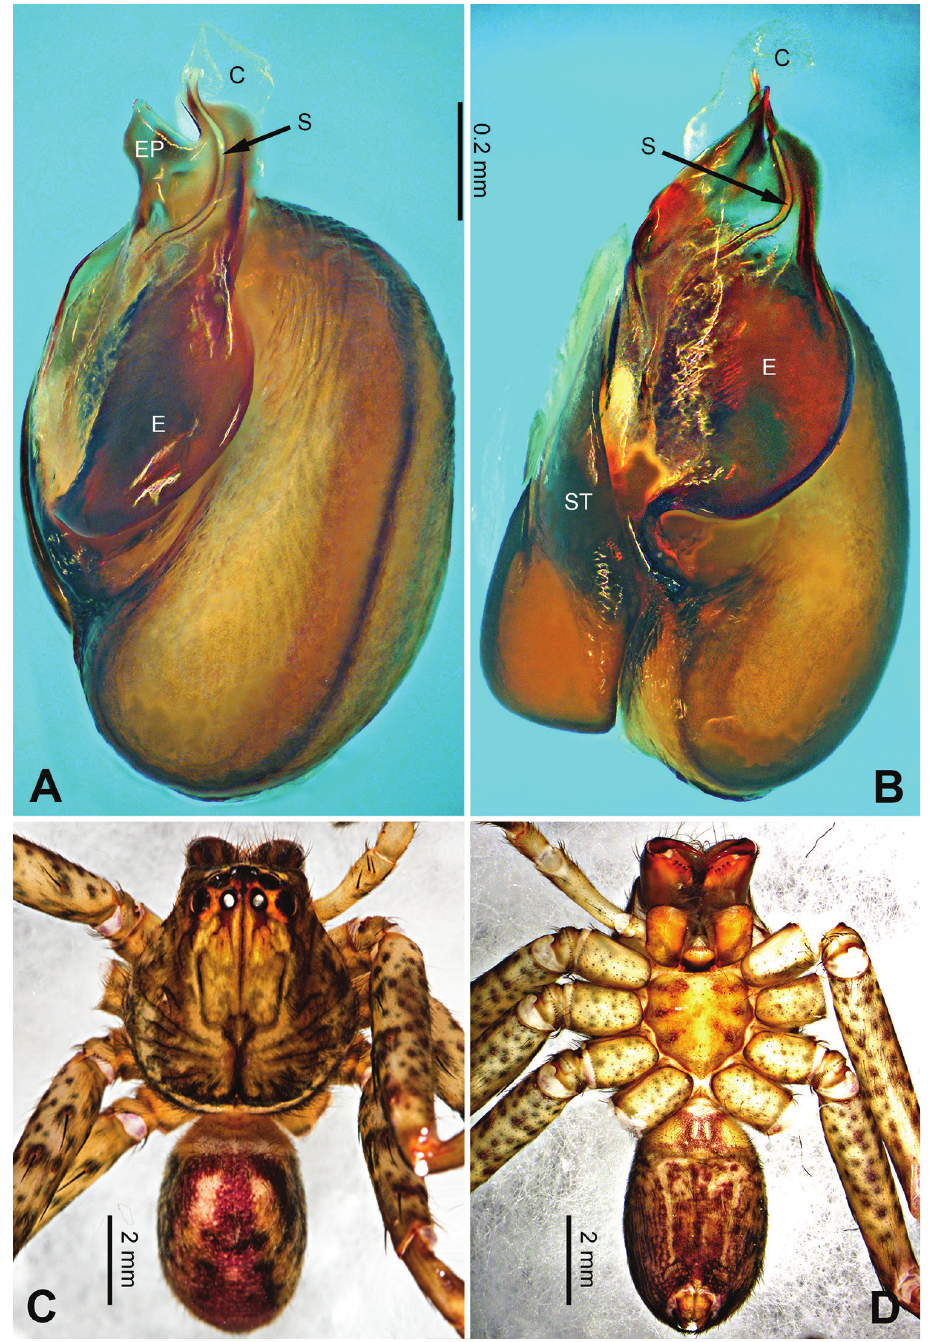
Figure 26. Pseudopoda subbirmanica Zhao & Li, sp. n., male holotype. A Bulb, ventral view B Bulb, dorsal view C Habitus, dorsal view D Habitus, ventral view. Scale bar equal for A, B